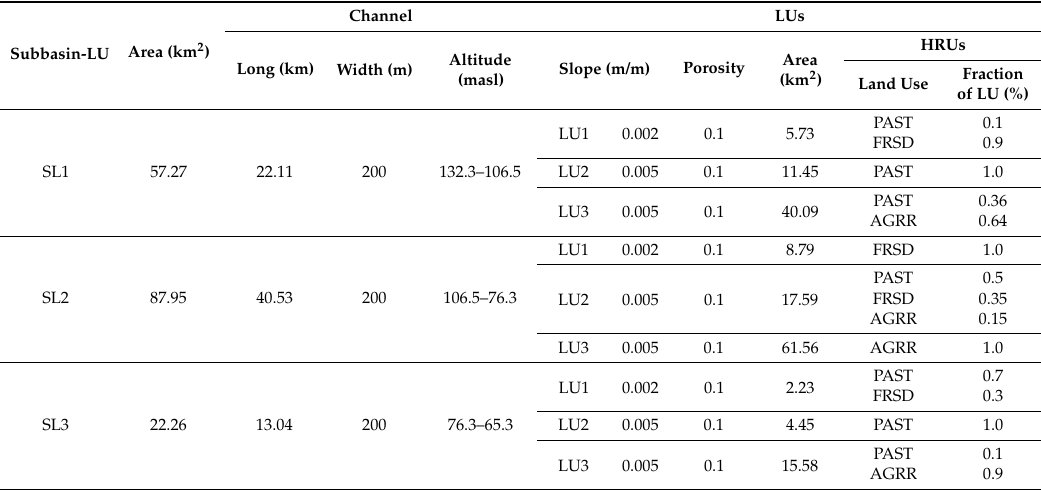
Table 1. Parameters for the three subbasin-LUs (SL1, SL2, and SL3), the LUs, and the HRUs included in the study site (PAST = pasture; FRSD = forest; and AGRR = agriculture).